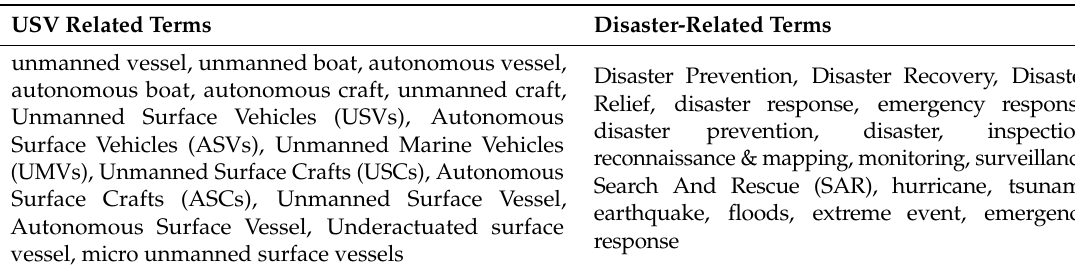
Table 1. List of keywords used in research databases.